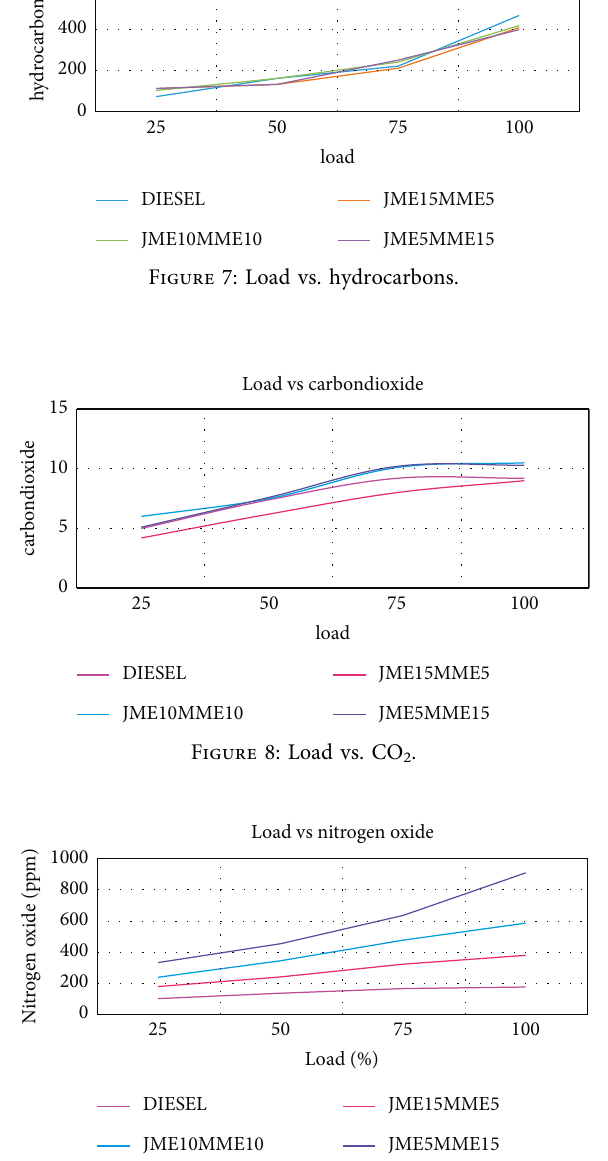
Figure 9: Emission of nitrogen oxides at various load.